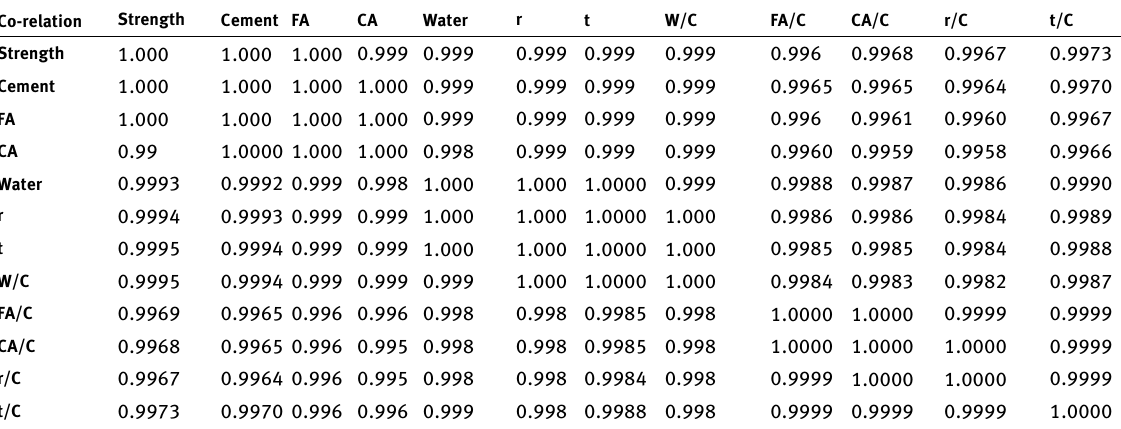
The plot for variation of eigen values with respect to